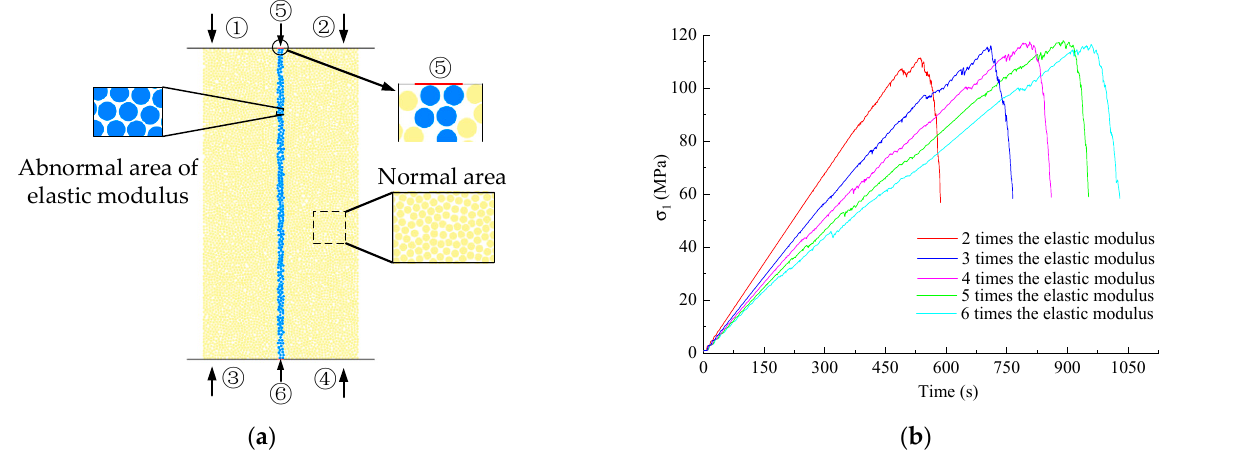
Figure 3. Rock model with abnormal elastic modulus and results of uniaxial compression test. ( a ) Elastic modulus abnormal area rock model; ( b ) Axial stress − time of rock with different elastic modulus.